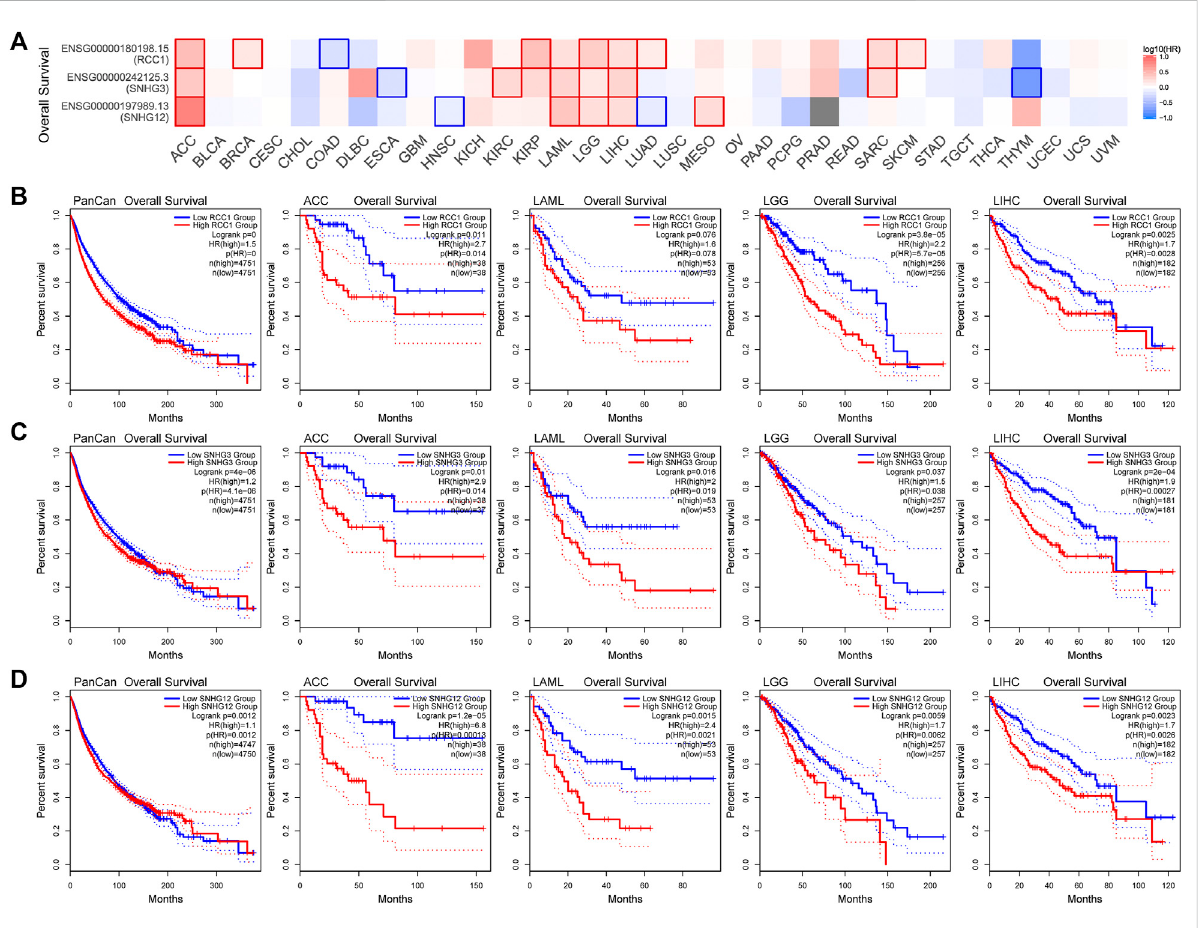
Correlation between RCC1/SNHG3/SNHG12 expression and overall survival of tumors. (A) Survival map of the correlation between the expression of RCC1/SNHG3/SNHG12 and the overall survival of patients in different tumors. (B – D) K-M plot of overall survival of PANCAN/ACC/